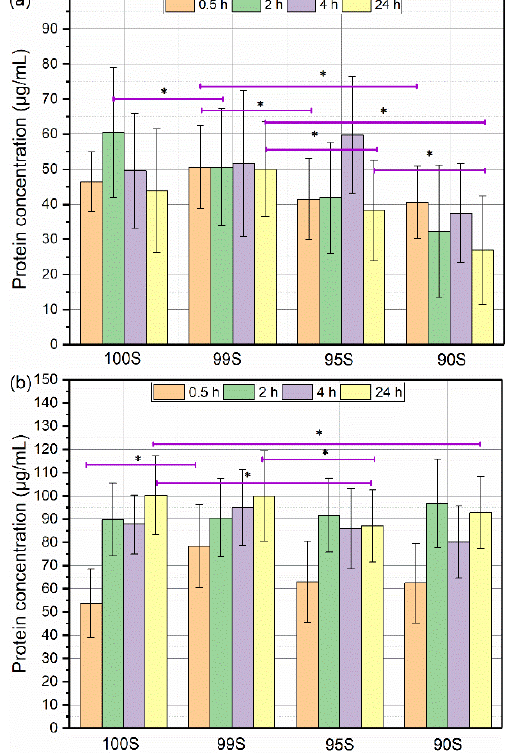
Figure 6. The concentrations of ( a ) BSA ( b ) lysozyme (LYZ) adsorbed on various BGNs after incubation for 0.5 h, 2 h, 4 h, and 24 h. Three technical repeats ( n = 3) were carried out within each experiment that was repeated in triplicate ( N = 3). Data are presented as mean ± SD and * indicates p < 0.05.